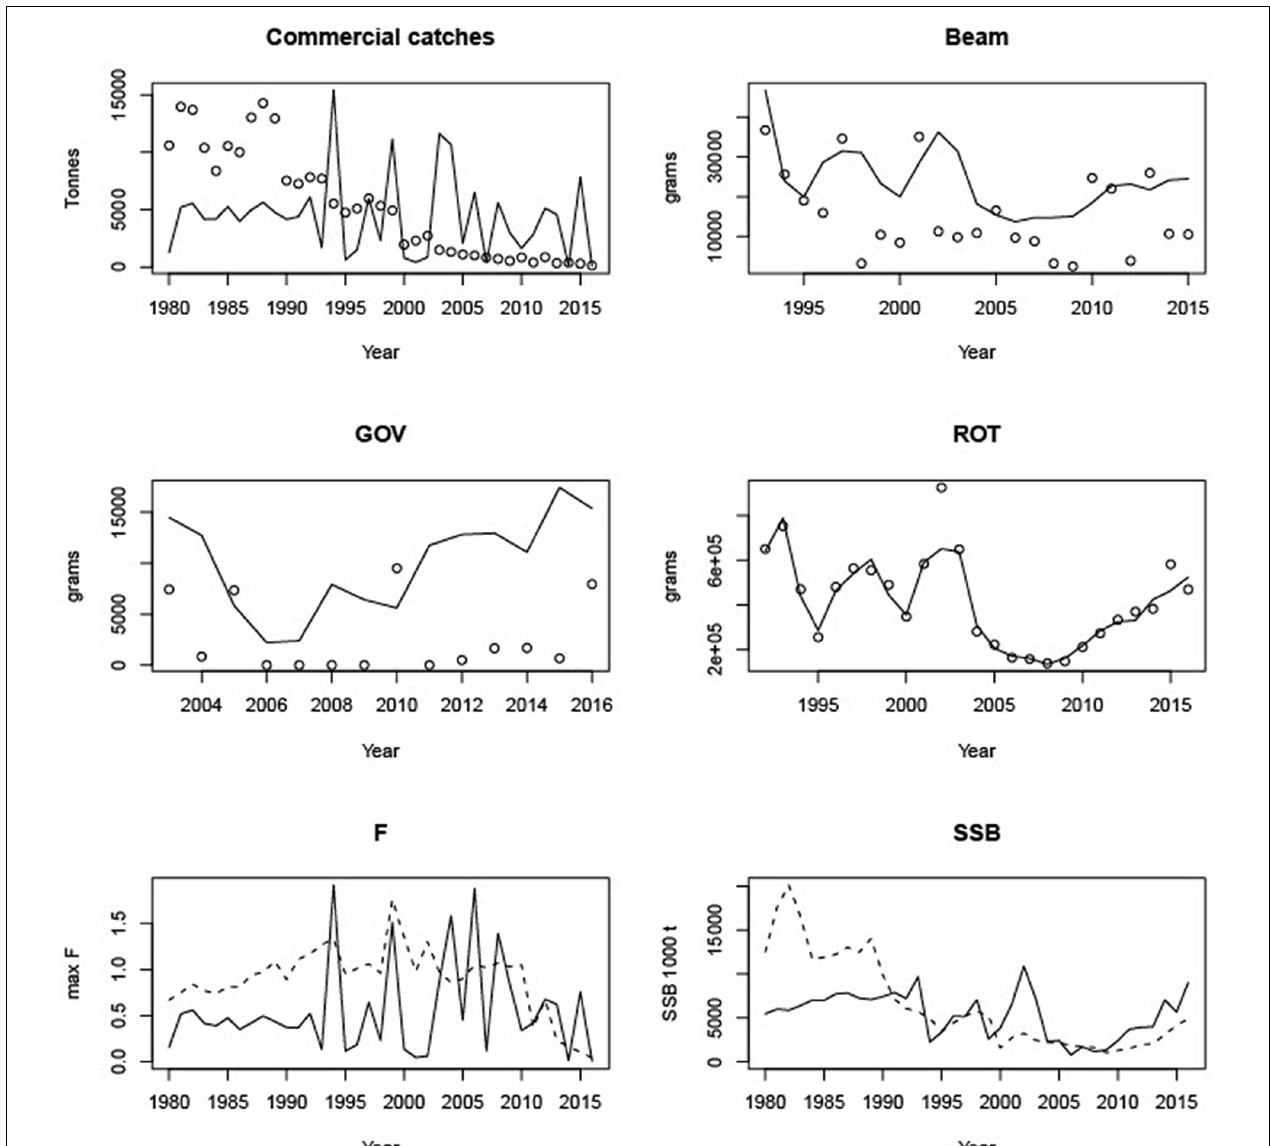
FIGURE 2 | Fits to commercial catches (CV = 0.1) and the three surveys (CV = 0.5) in the top 4 panels, and comparison of estimates of F and SSB with single species assessments for cod. In each case the model is the solid